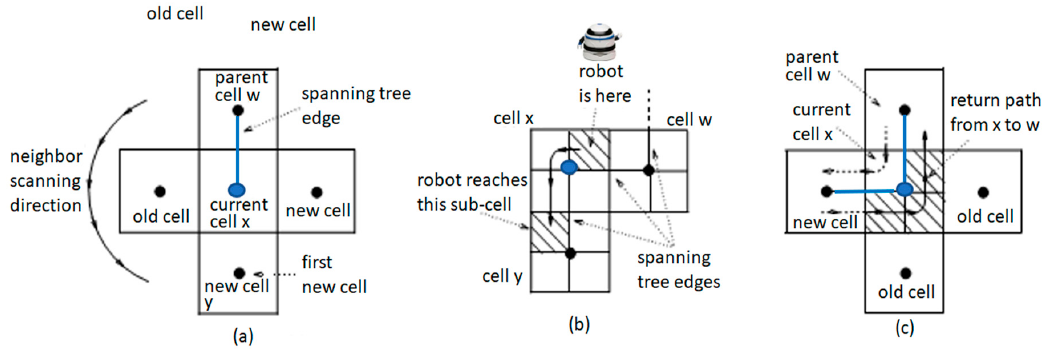
Figure 3. ( a ) Counterclockwise scanning of four neighbors. ( b ) a move from x to a new cell y. ( c ) a return from x to a parent cell w.